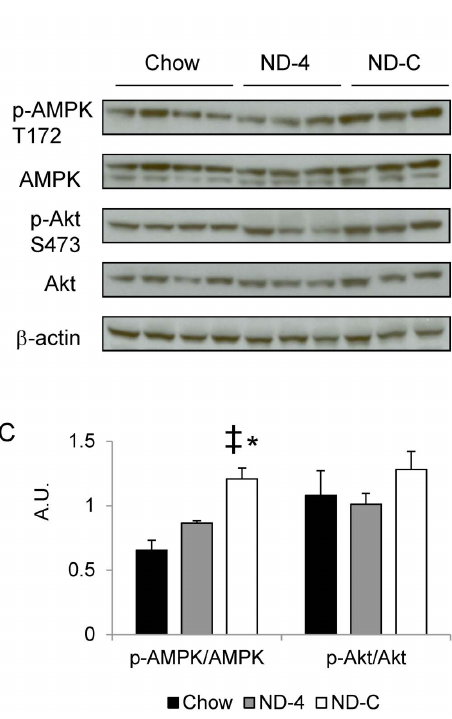
Figure 4. PDK4 mRNA expression (A) and activation ratio of AMPK and Akt (B) in the muscle from chronically catheterized conscious insulin treated depancreatized dogs that were either on a chow diet or fed isocaloric nutritional support as a constant infusion (ND-C) or once a day for 4 days (ND-4). mRNA expression is represented as Rq (relative expression to endogenous and control group). Western blot images are representative of three experiments. Ratios are calculated as the average of phosphorylated protein divided by total amount of protein and represented in arbitrary units (A.U.). * and ` indicate significantly different from chow and ND-4, respectively (p , 0.05).